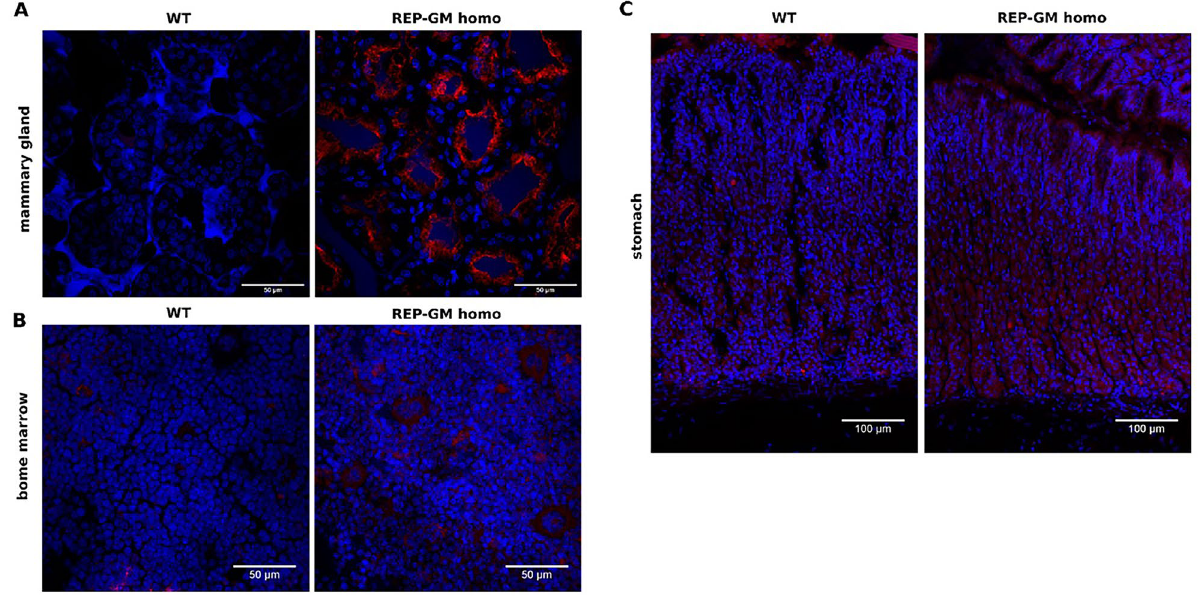
Figure 4. Tissue sections from lactating wild-type and REP-GM homozygous mice stained with anti-GMCSF antibodies (red). Nuclei were stained using DAPI (blue). Scale bars represent 50–100